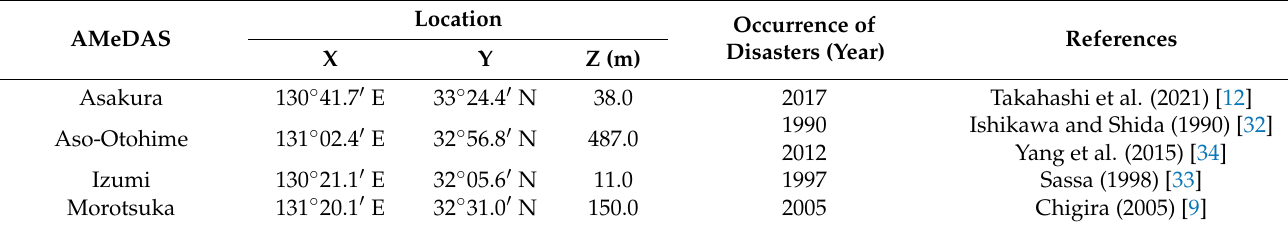
Table 2. Specifications of